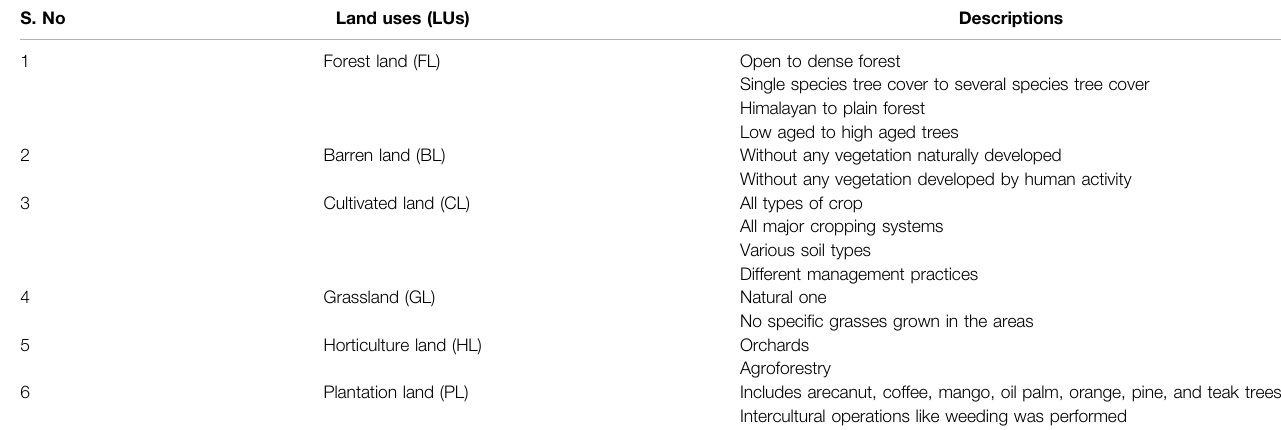
TABLE 1 | Descriptions of Land uses (LUs) in the